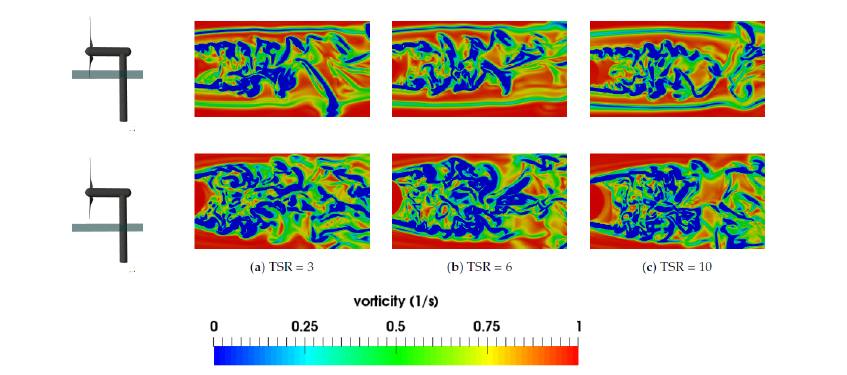
Figure 15. HAWT S826: Vorticity plots exhibiting the formation of coherent structures in two spatial dimensions. Wake is composed of small eddies whose length and shape depends on the operating TSR. The eddies generated by the tower have distinct patterns to those from the combined rotor and tower. Note: the vorticity magnitude is restricted to 0–1 m/s to provide better contrast.